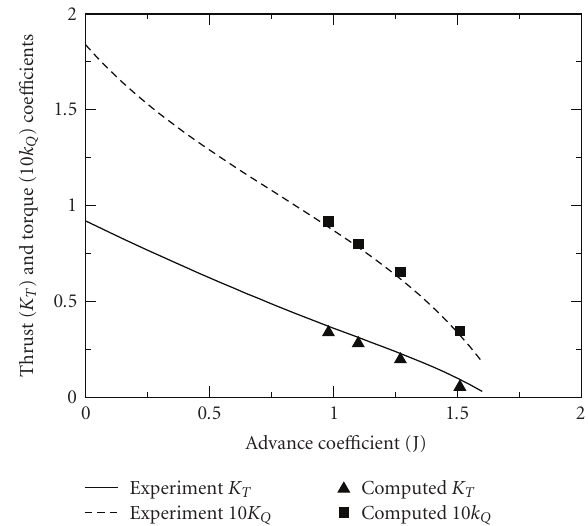
Figure 9: Convergence histories of marine propeller 5168.